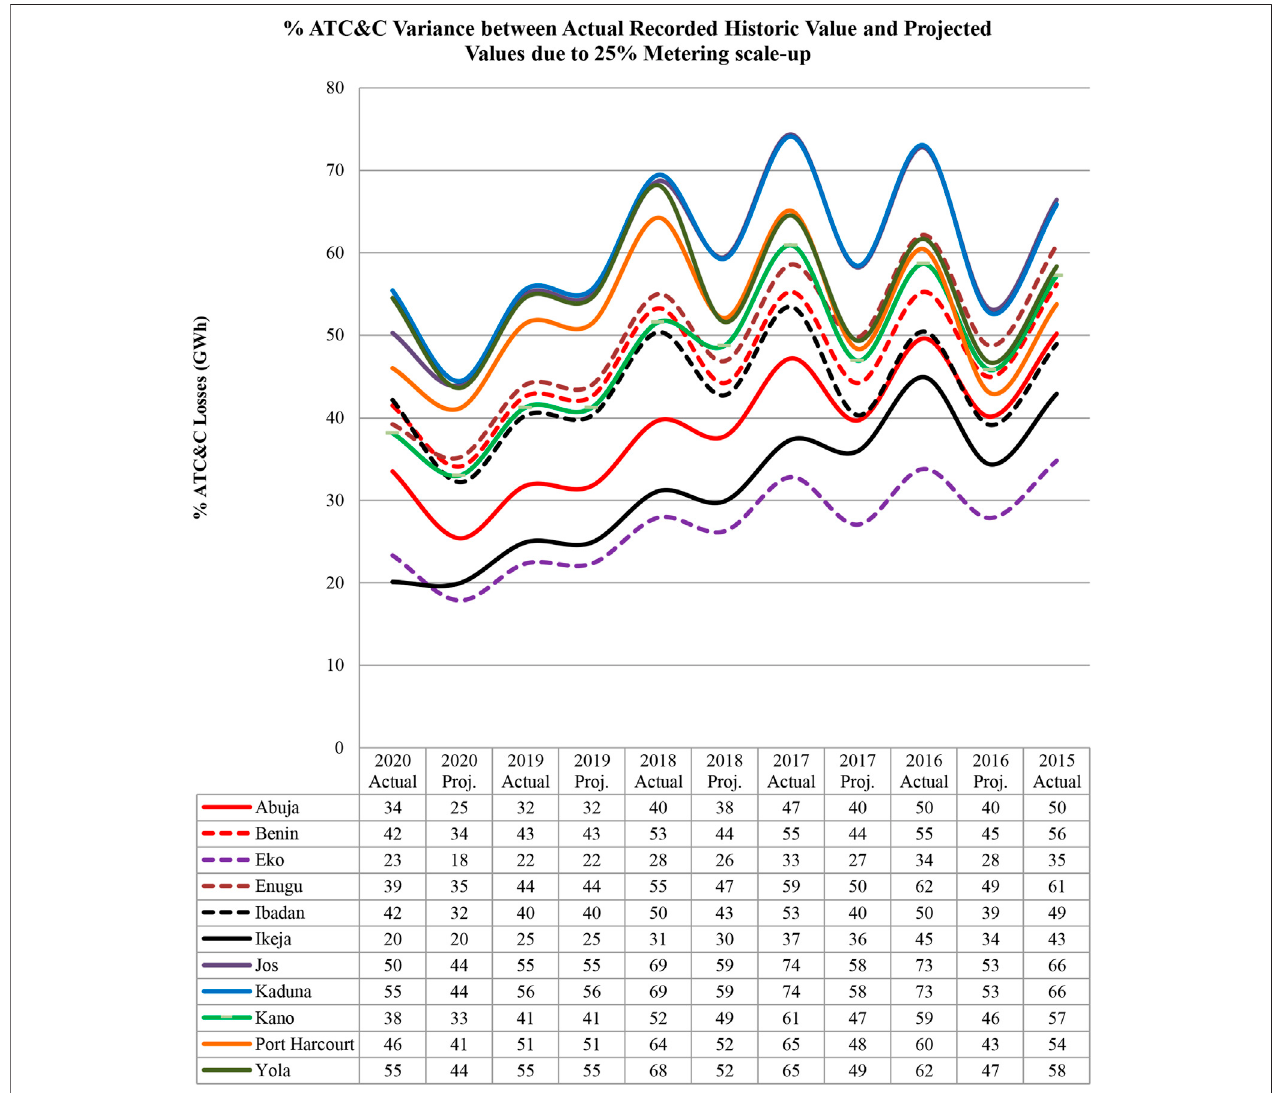
FIGURE 4 | % ATC&C variance between the actual recorded historic value and projected values due to 25% metering scale-up.